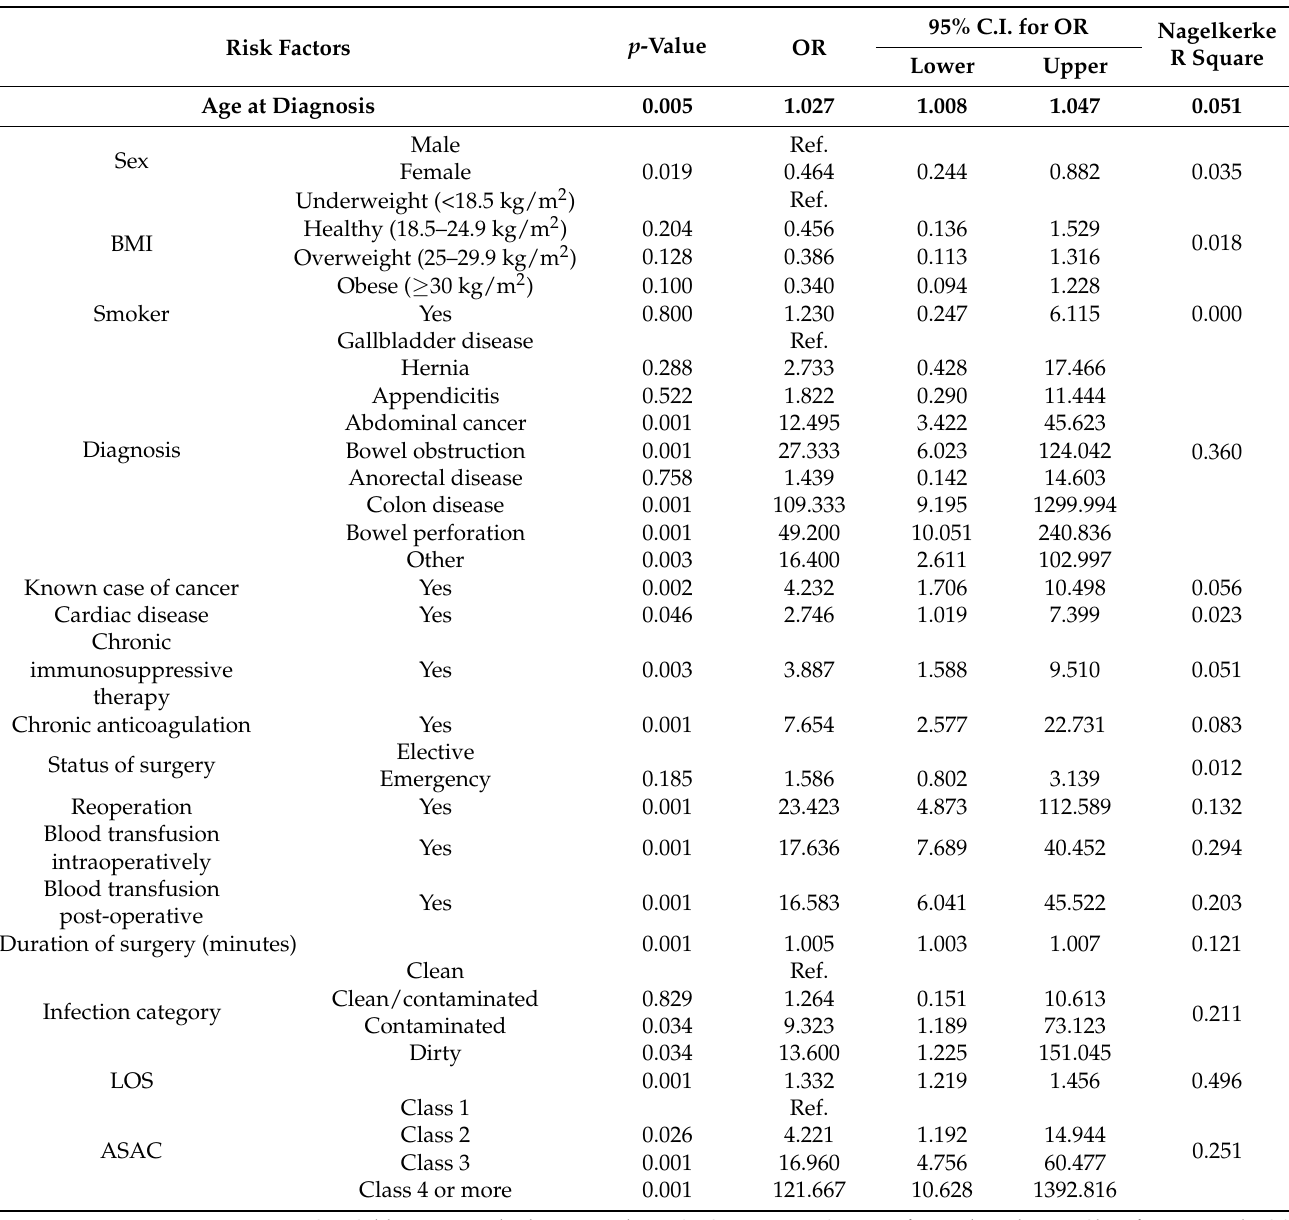
Table 4. Binary logistic regression (Univariate) of patients who developed post-operative complica- tions during the lockdown. ( n =